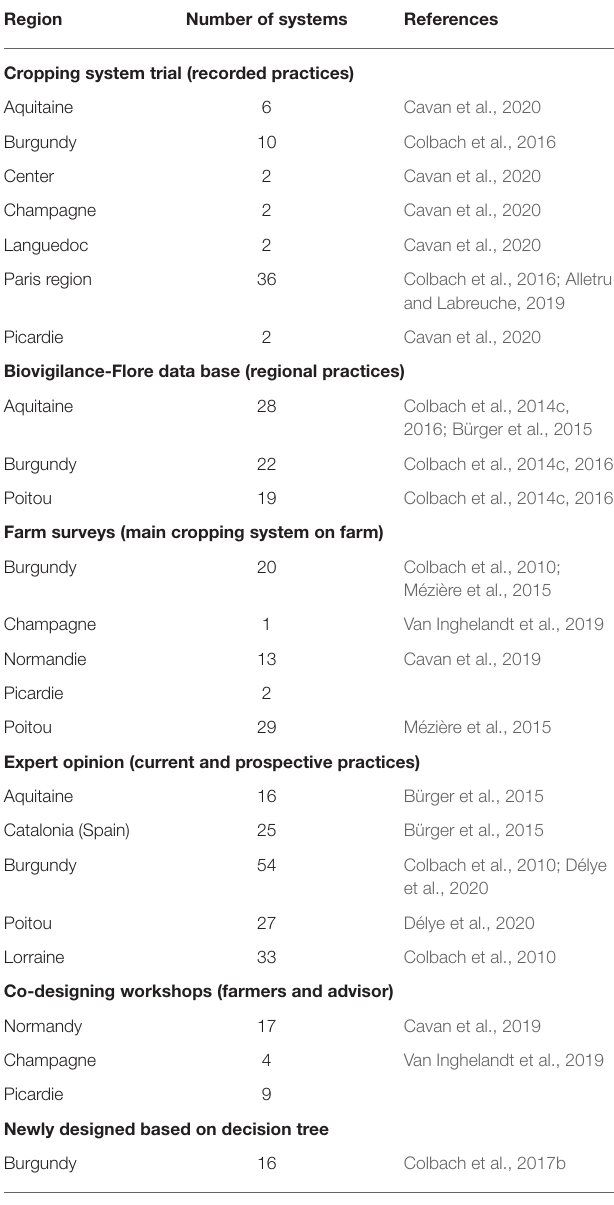
TABLE 1 | Summary of the 395 cropping systems used in the simulation study (further details in Section B.1 in Supplementary Material